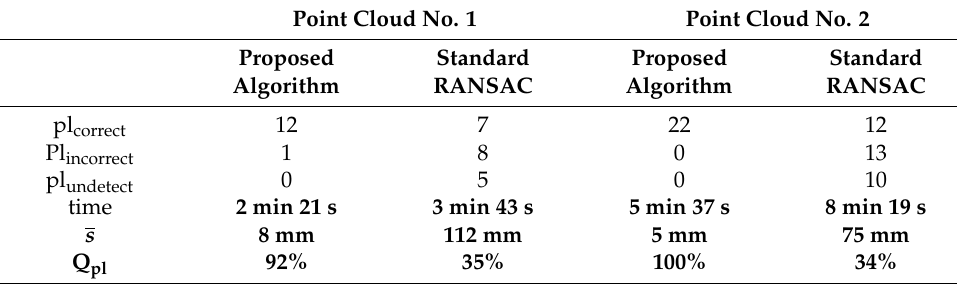
Table 3. Characteristics of plane segmentation.